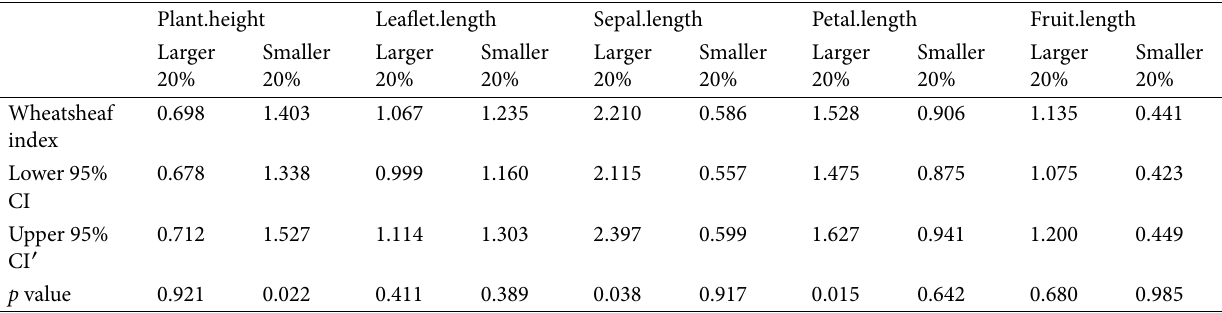
Table 3 Analysis of convergent evolution using the Wheatsheaf